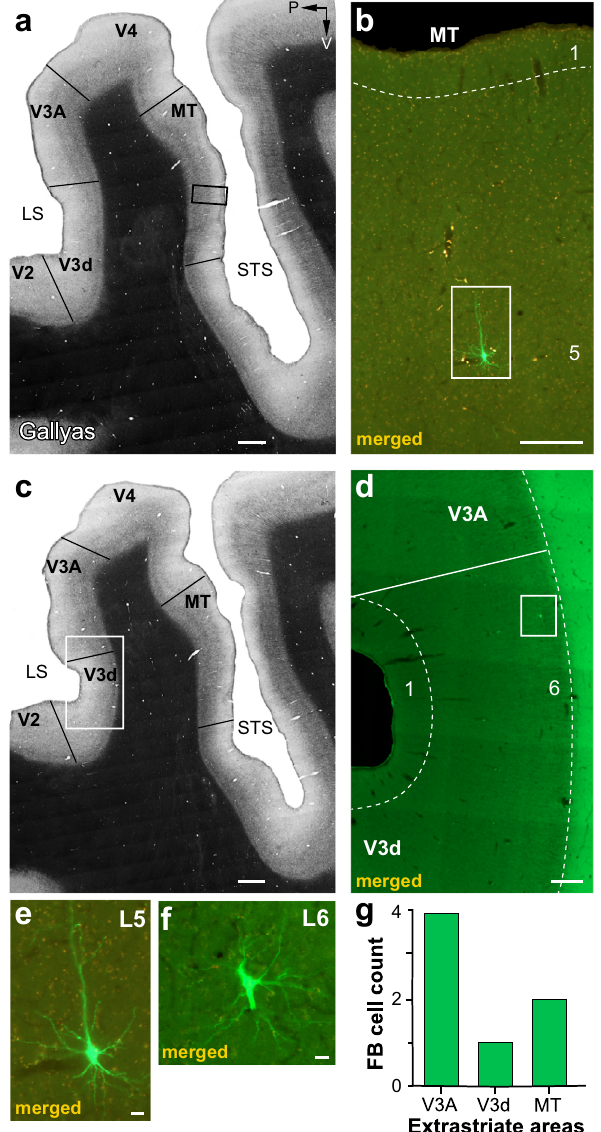
Fig. 6 Case MK379: FB inputs from the higher extrastriate cortex. a Image of a sagittal section through the extrastriate cortex encompassing the anterior bank of the lunate sulcus (LS), the prelunate gyrus, and the banks of the superior temporal sulcus (STS), stained for myelin using the Gallyas method to reveal areal borders (solid black lines). P: posterior; V: ventral. b Higher magni fi cation of the MT region inside the black box in ( a ) in an adjacent section imaged for GFP and mCherry fl uorescence and merged. A single GFP-labeled pyramidal cell is visible in L5 (inside the white box) and shown at higher magni fi cation in ( e ). c Same as in ( a ) but for a different section. d Higher magni fi cation of the V3d/V3A region inside the white box in ( c ) viewed under fl uorescence. A single GFP-labeled cell is visible in L6 of dorsal V3 (V3d) (inside the white box) and shown at higher magni fi cation in ( f ). e , f GFP-labeled cells in MT L5 and V3d L6, respectively. Scale bars: 1 mm ( a – c ), 250 µ m ( b , d ), 20 µ m ( e , f ). g Number of GFP-labeled cells in higher extrastriate